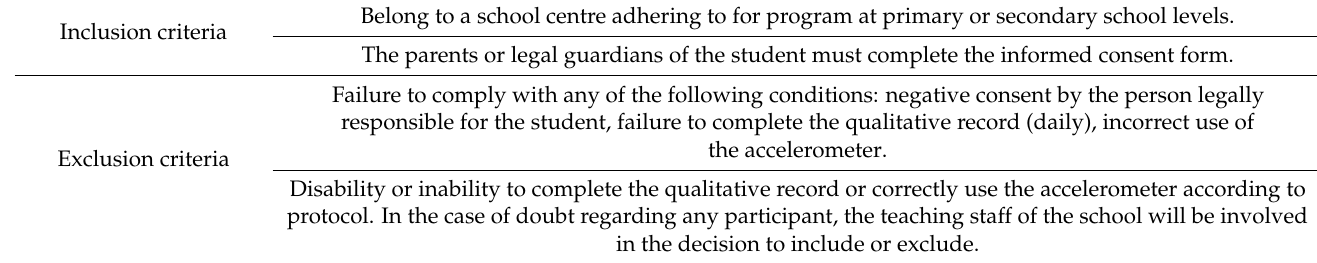
Table 2. SEP term assigned to each group. Table 1. Inclusion and exclusion